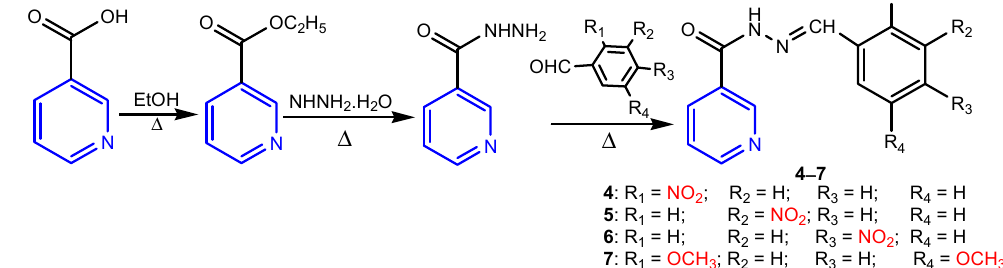
Scheme 2. Synthesis of nicotinic acid benzylidene hydrazide derivatives 4 − 7